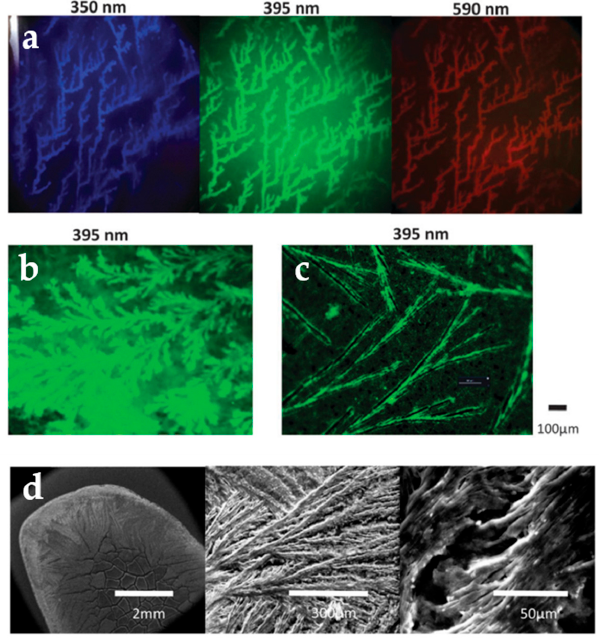
Figure 7. Fluorescence microscopy images of nanotags: ( a ) on glass slides; ( b ) on glass slide at higher concentration; ( c ) on polymer surface; ( d ) under SEM at different magnifications. The excitation wavelengths are indicated. Reproduced from reference [42] with permission of The Royal Society of Chemistry. Nanomaterials 2020 , 10 , x FOR PEER REVIEW